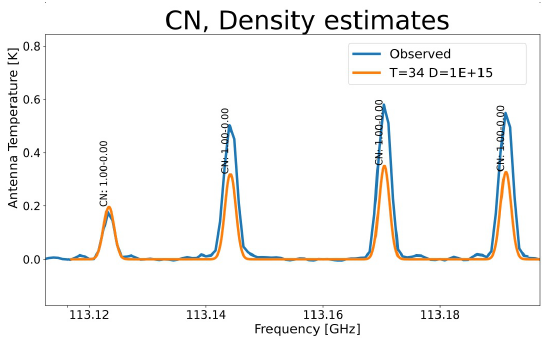
Figure 6. Fitting of CN lines with a single layered